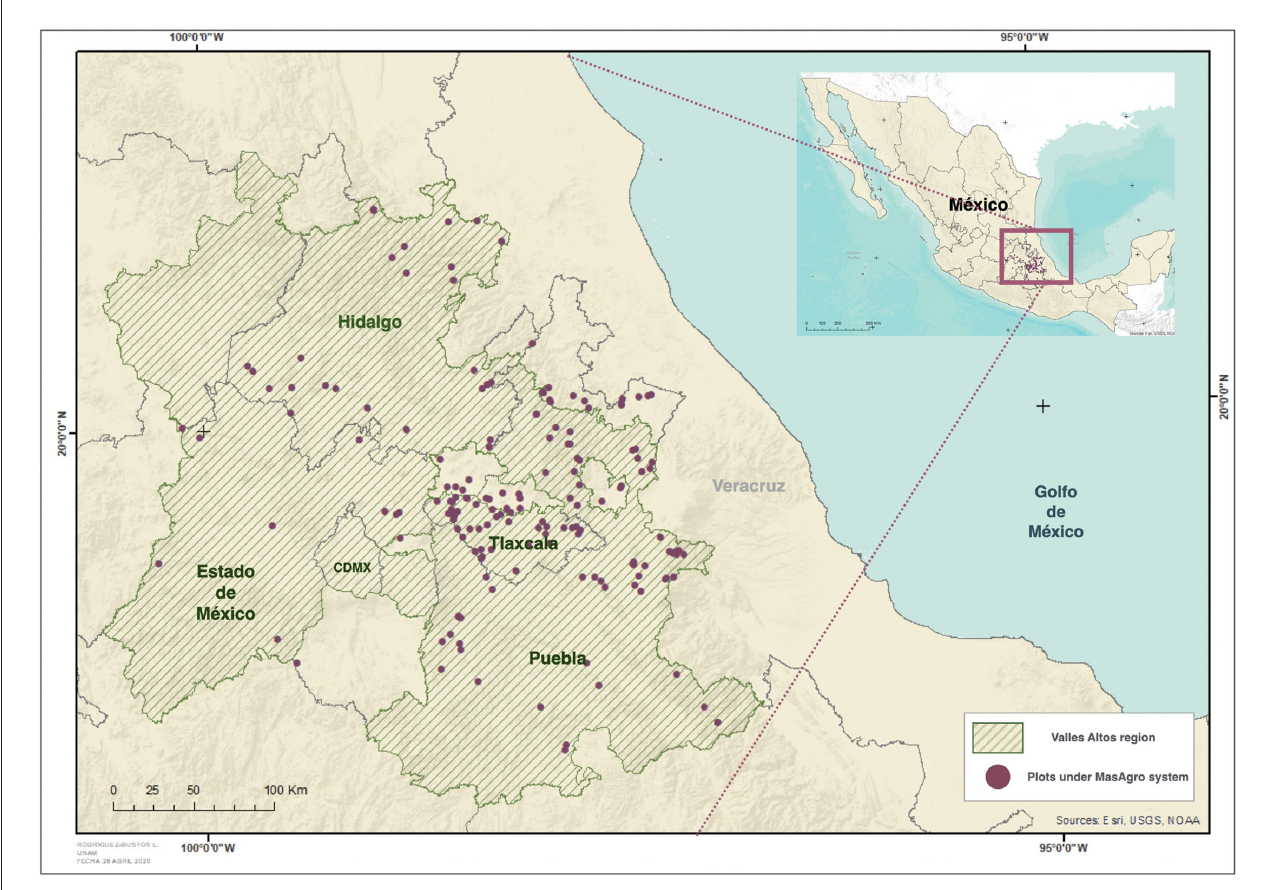
FIGURE1 Location map of Mexico highlands. The Mexico highlands region states are shown in green; the plots considered in this study are marked